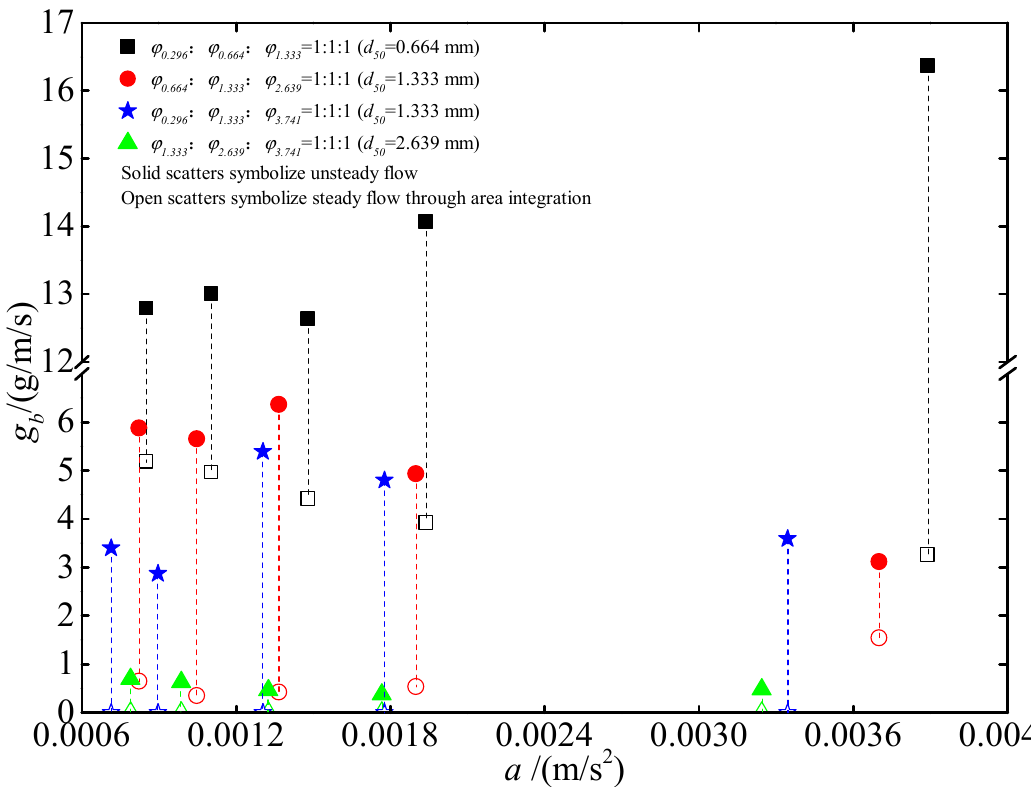
Figure 9. Transport rate comparison between steady flow obtained through unsteady flow area integration and unsteady flow under four non-uniform sand conditions.